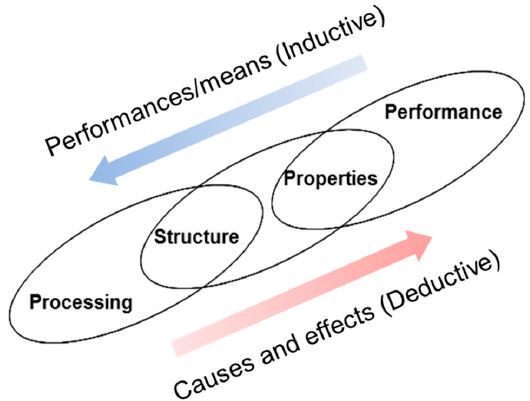
Figure 1. Olson’s hierarchical concept of “Materials by Design” [1].